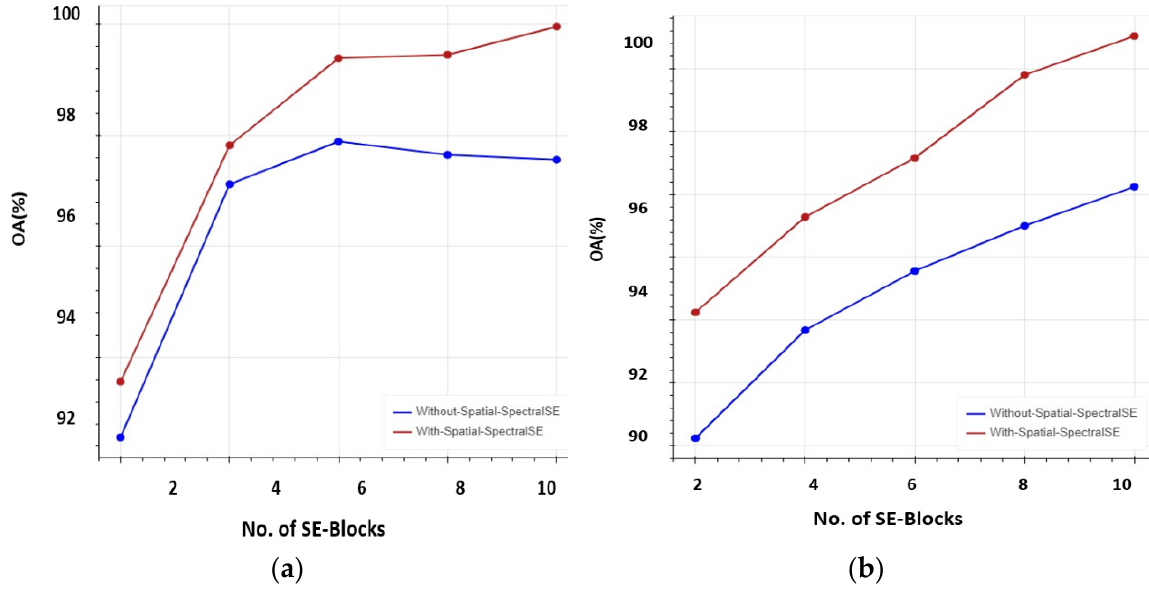
Figure 13. With and without spatial–spectral SE blocks vs. overall accuracy (OA%): ( a ) 5% training samples; ( b ) 10% training samples.